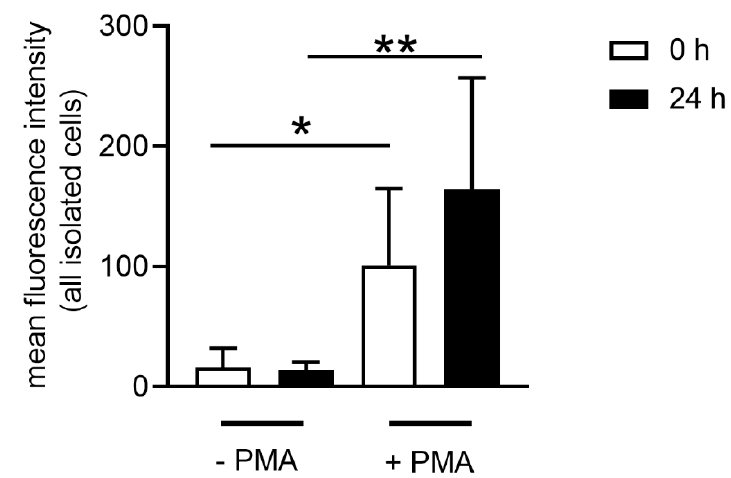
Figure 5. Isolated neutrophils from stored blood produced higher amounts of intracellular reactive oxygen species (ROS) after phorbol 12-myristate 13-acetate (PMA) stimulation. The intracellular ROS production was determined by adding 2 ′ 7 ′ dichlorofluorescein diacetate (DCFH-DA) to unstimulated and PMA-stimulated cells. Oxidation of DCFH-DA by ROS leads to fluorescence 2 ′ ,7 ′ - dichlorofluorosceindiacetate (DCF). The fluorescence-positive cells were quantified by flow cytometer. Data were analyzed with one-tailed unpaired Student’s t -test ( n = 3 experiments with duplicates are presented). Data are presented with mean ± SD (* p < 0.05, ** p < 0.01).